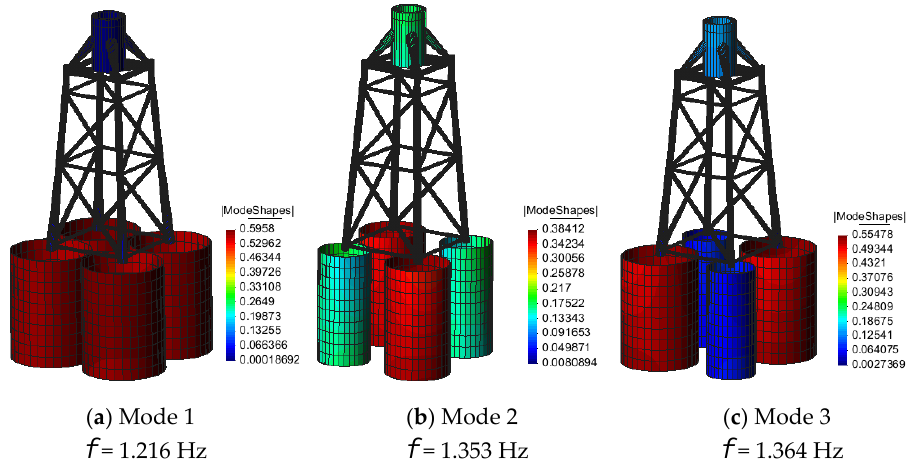
Figure 14. Mode shapes of the jacket-suction bucket piles with soil behavior using Jeanjean’s method ( a ) 1 st mode shape; ( b ) 2 nd mode shape; ( c ) 3 rd mode shape.